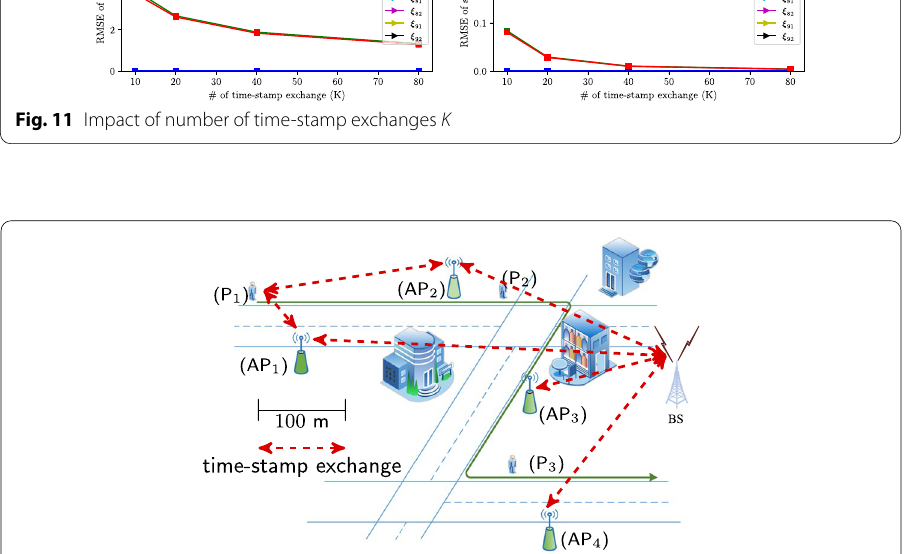
Fig. 12 An example where MU joint sync&loc can be carried out. In each position, e.g., P 1 , P 2 , or P 3 , the MU is exchanging time-stamps with at least two APs based on the protocol described in Sect.